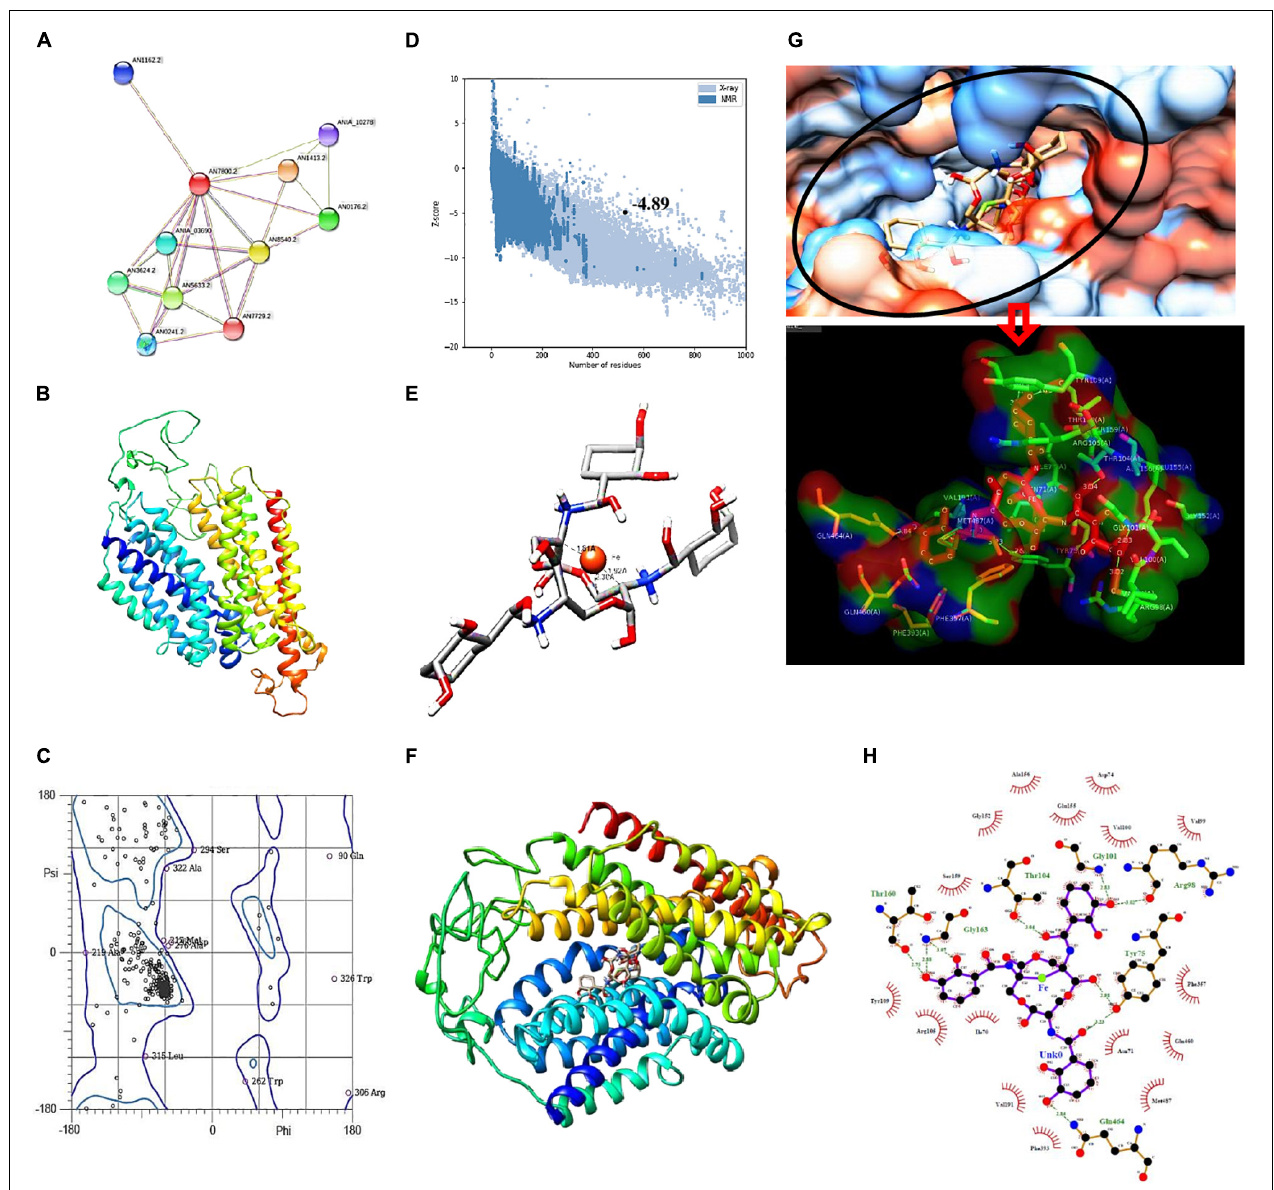
FIGURE 7 | (A) STRING analysis showing protein–protein interaction for siderophore import in A . nidulans . Green lines connect proteins that are associated by recurring neighborhood, blue connections are inferred by phylogenetic co-occurrence, and red lines indicate gene-fusion events; line thickness is a rough indicator for the strength of the association. Number of nodes: 11, number of edges: 25, average node degree: 4.55, average local clustering coefficient: 0.776. (B) Structure of MirA generated by SWISS-MODEL. (C) Ramachandran plot of MirA model. (D) Z -score plot generated by ProSA web server for MirA model. (E) Docked complex of Enterobactin (Stick) and Iron (Ball) with distance measurement between Fe and C. (F) Docked complex of MirA with Ent–Fe complex. (G) Binding pocket of MirA as visualized in hydrophobicity surface mode, inset: interacting residues of MirA (surface) with Ent–Fe complex (stick). (H) Interaction plot generated by Ligplot+; green dotted lines represent hydrogen bonds with